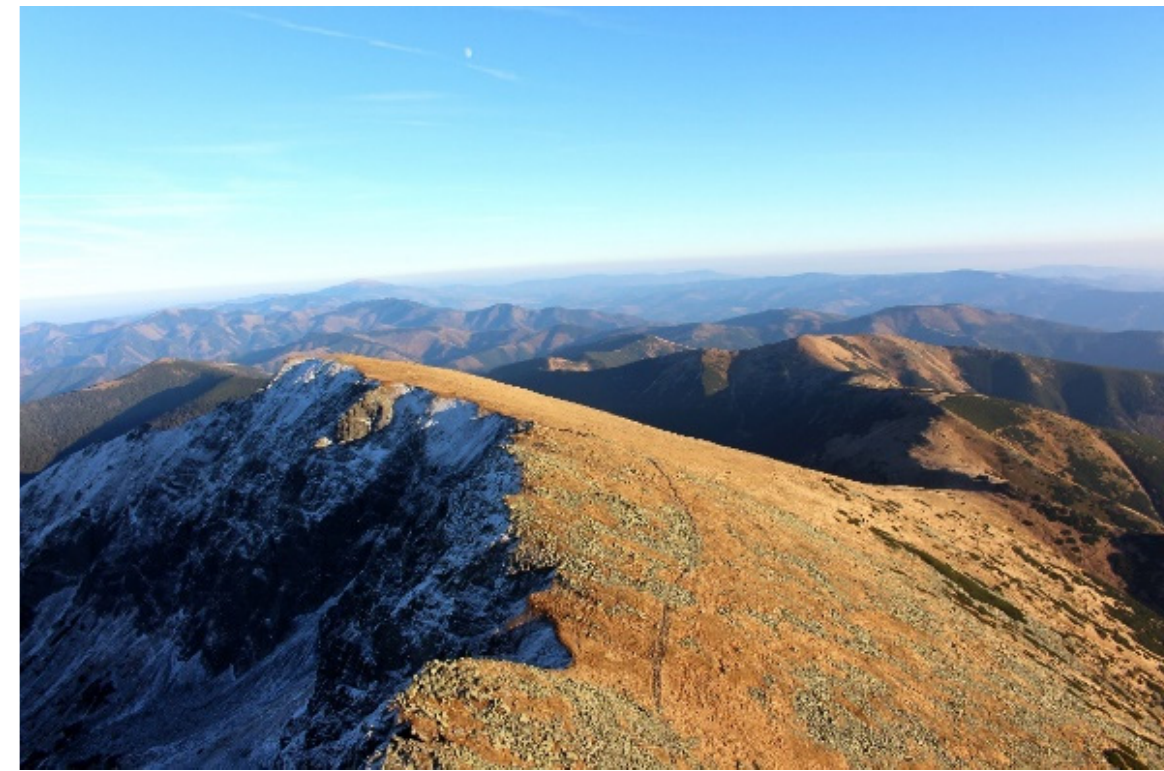
Figure 7. Ď umbier mountain ridge (2045 m a. s. l.), the highest peak of the Ď umbier Tatras (photo Figure 7. ˇDumbier mountain ridge (2045 m a. s. l.), the highest peak of the ˇDumbier Tatras (photo by: P. by: P. Urban).